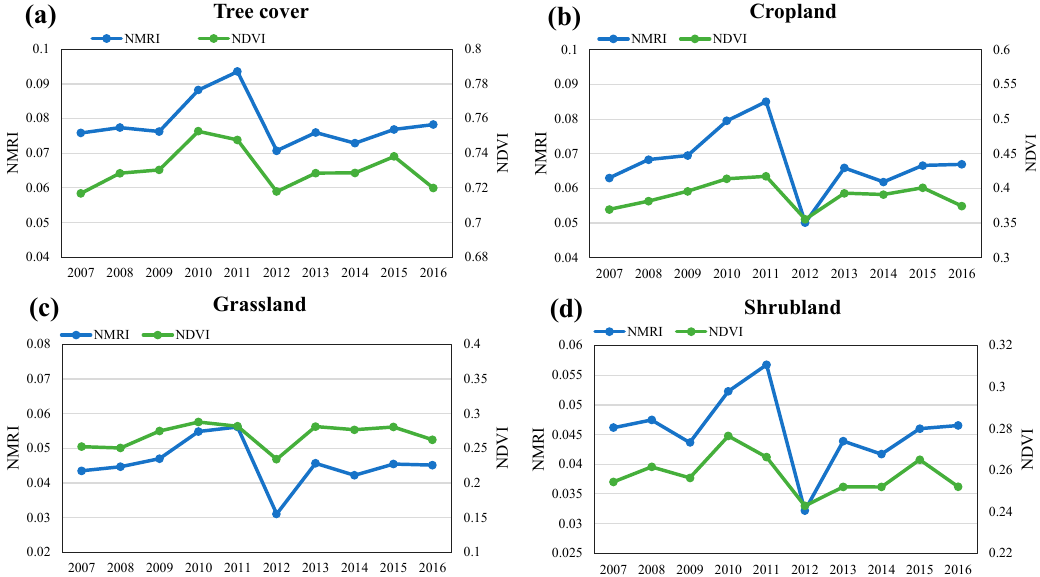
Figure 13. NMRI and NDVI long time-series variation diagrams of the four land cover types in July from 2007 to 2016: ( a ) tree cover; ( b ) cropland; ( c ) shrubland; ( d ) grassland.